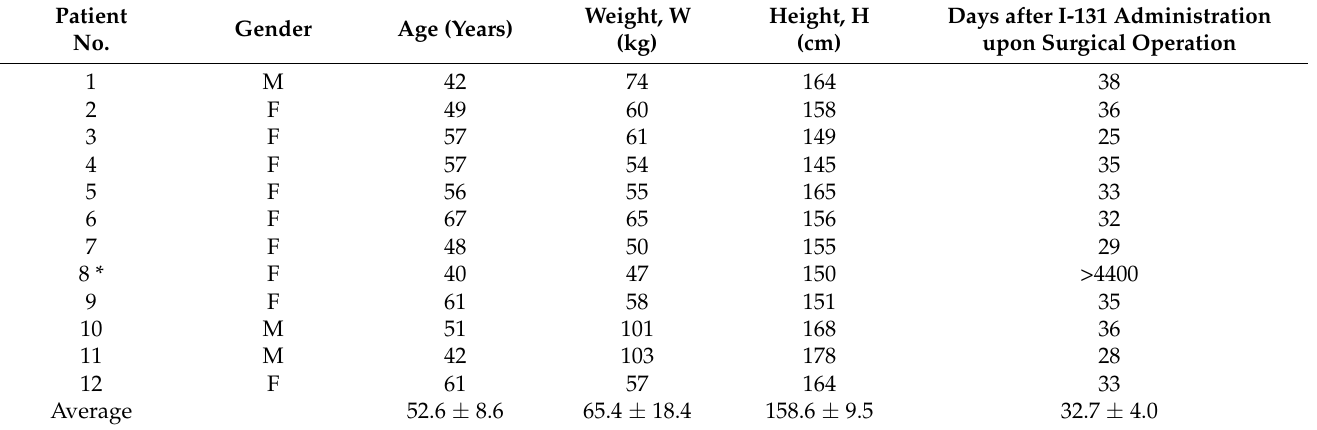
Table 1. Characteristics of twelve patients with a papillary thyroid cancer diagnosis who under- went the whole-body scanning for further analysis of the iodine biokinetic model. * Case No. 8 was diagnosed as having a relapse of hyperthyroidism after partial ablation of the thyroid gland 12 years